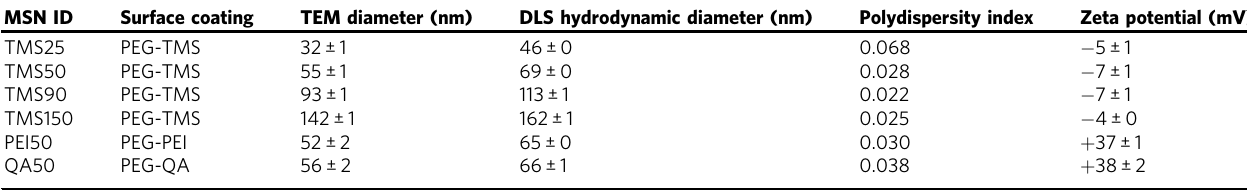
Table 1 MSN characterization (size, polydispersity index, and zeta